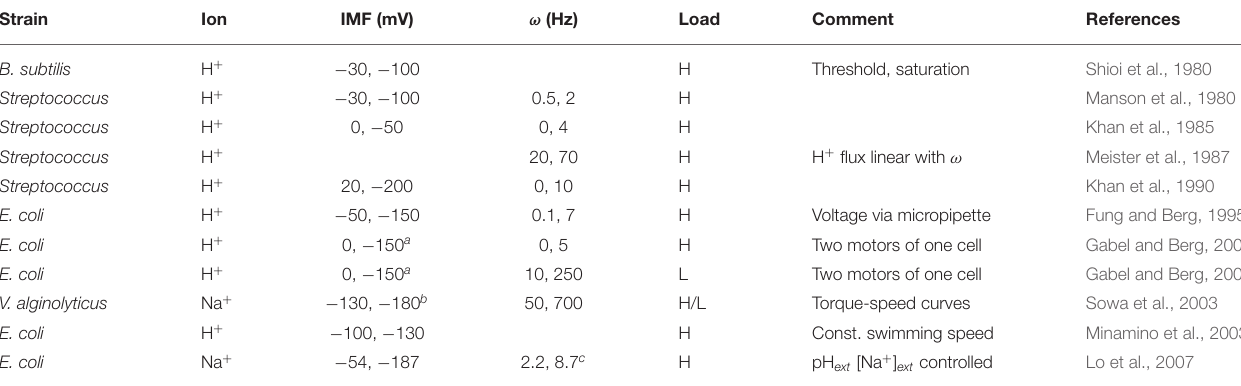
TABLE 1 | Published linearity ranges between motor speed ω and ion motive force (IMF) in different strains. Strain Ion IMF (mV) ω (Hz)